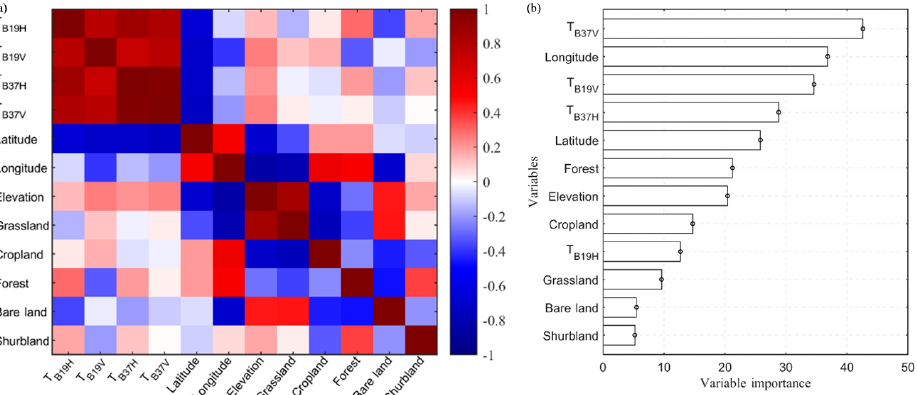
Figure 3. Correlations between the predictor variables (a) and the ranking of variable importance (b) . The importance of variables, referred to as mean decrease accuracy (MDA) in the RF model, is obtained by averaging the difference in out-of-bag error estimation before and after the permutation over all trees. The larger the MDA, the greater the importance of the variable is.